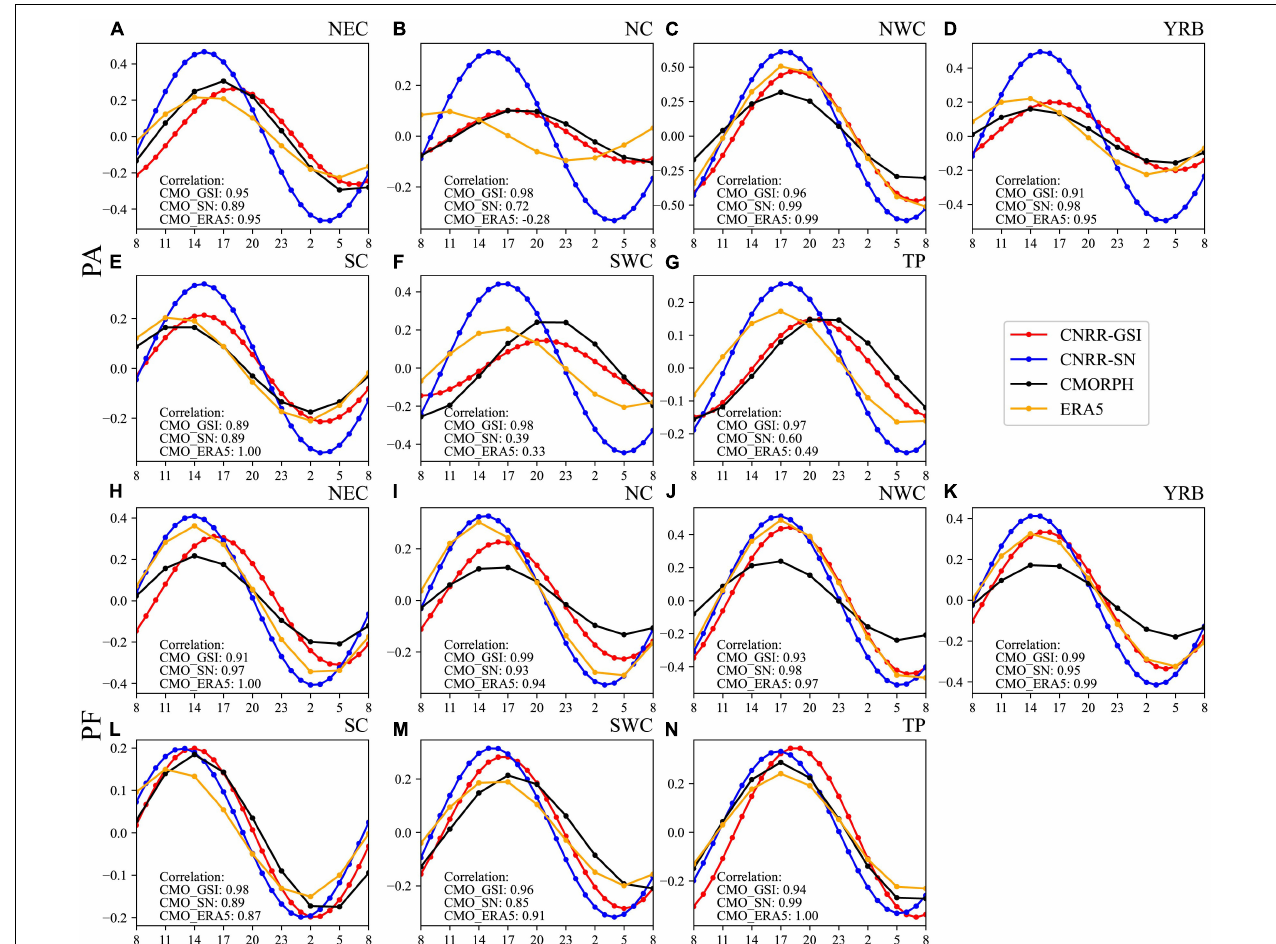
FIGURE 10 | The normalized diurnal harmonic cycle of PA (A–G) and PF (H–N) from CNRRs, ERA5, and